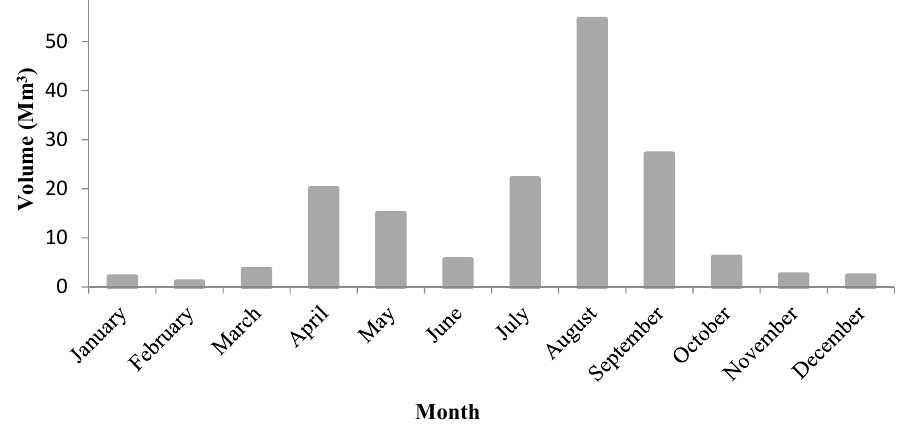
Figure 3. Average inflow values based on a 15-year historical period [15].